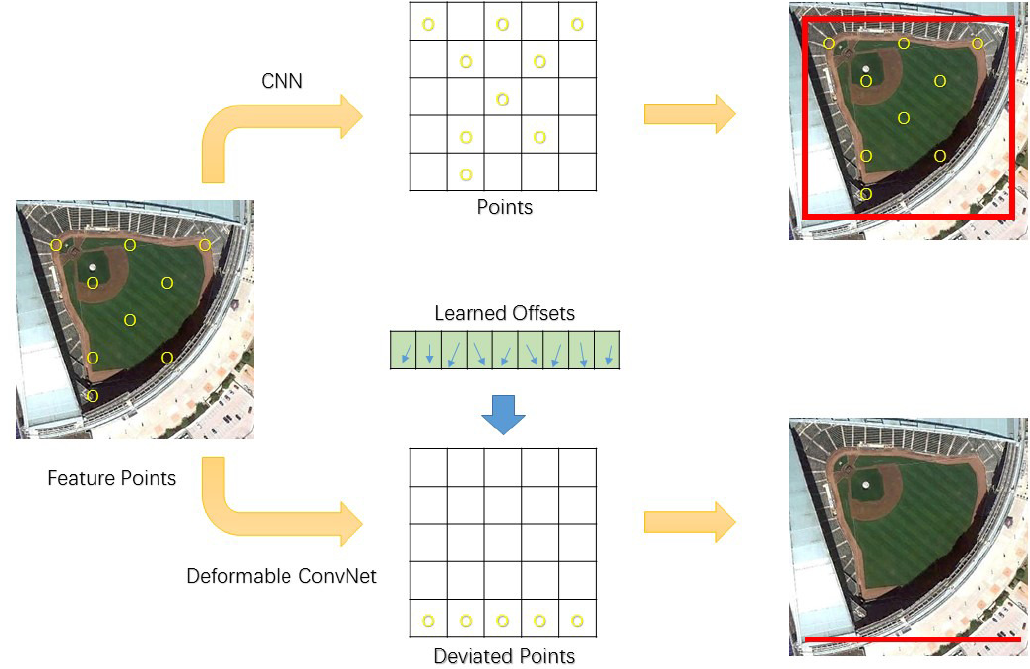
Figure 3. Illustration of lines like false region proposals (LFRP, bottom right) generated by classic deformable